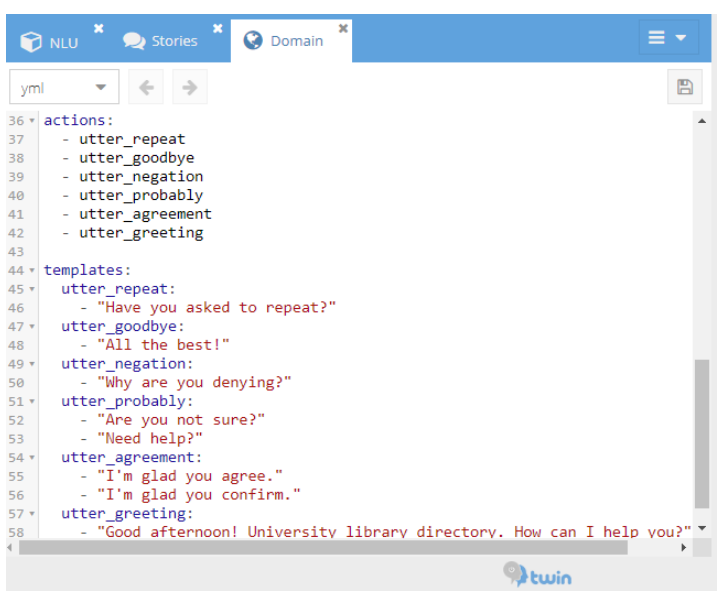
Fig. 6. Intentions, entities, slots and actions of the